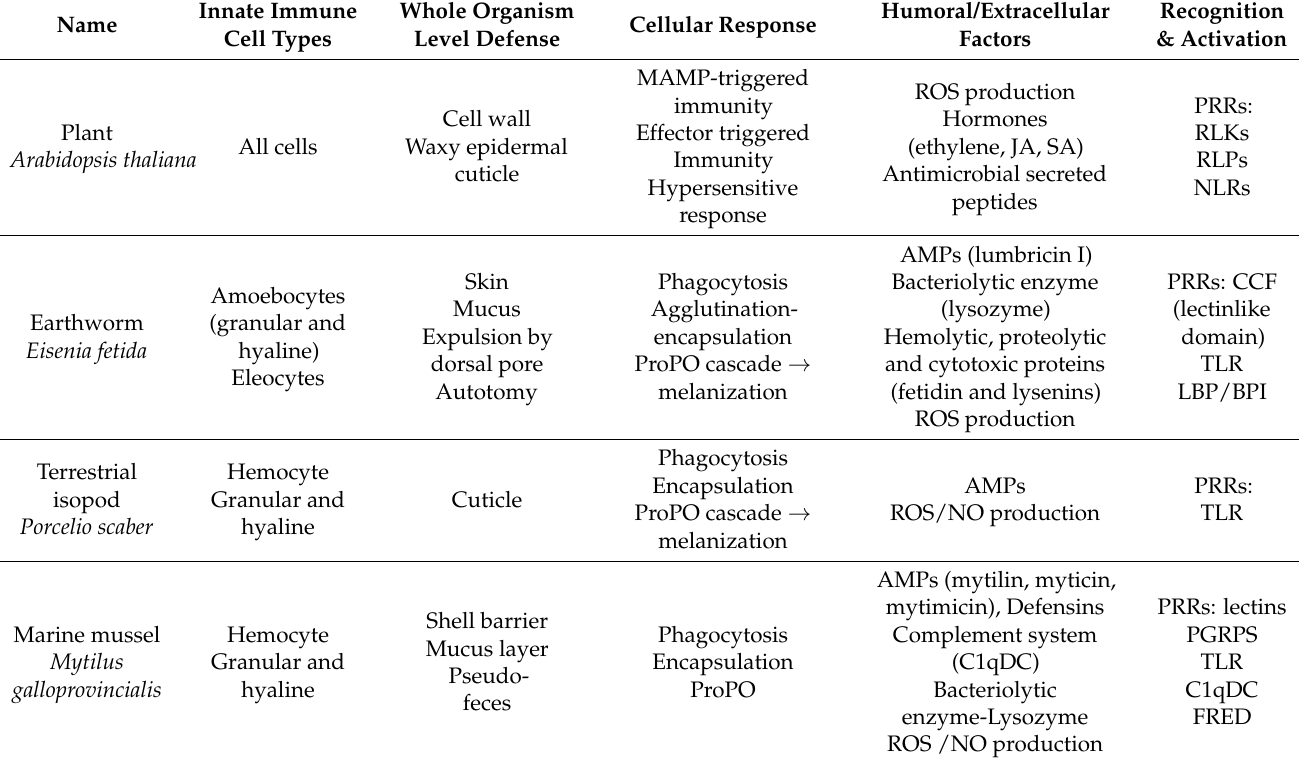
Table 1. Summary of the main defense mechanisms involved in innate immunity at different levels of the models